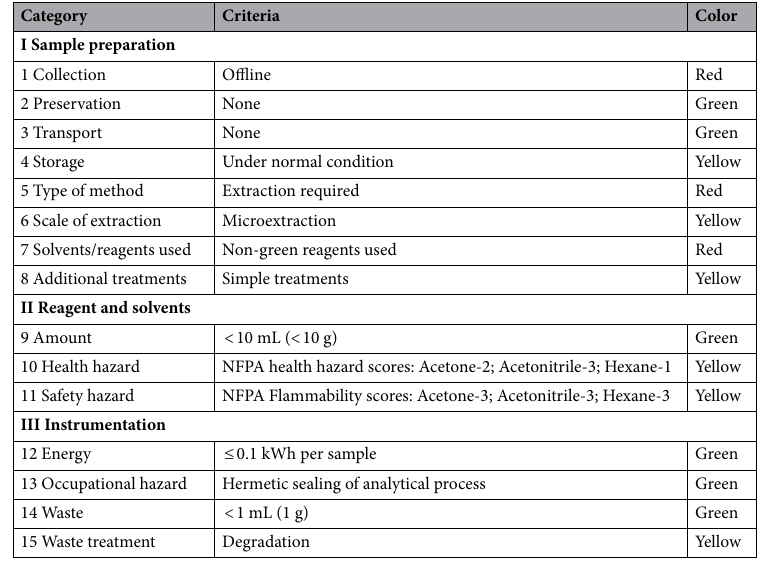
Table 4. Green Analytical Procedure Index estimation of the developed analytical method.